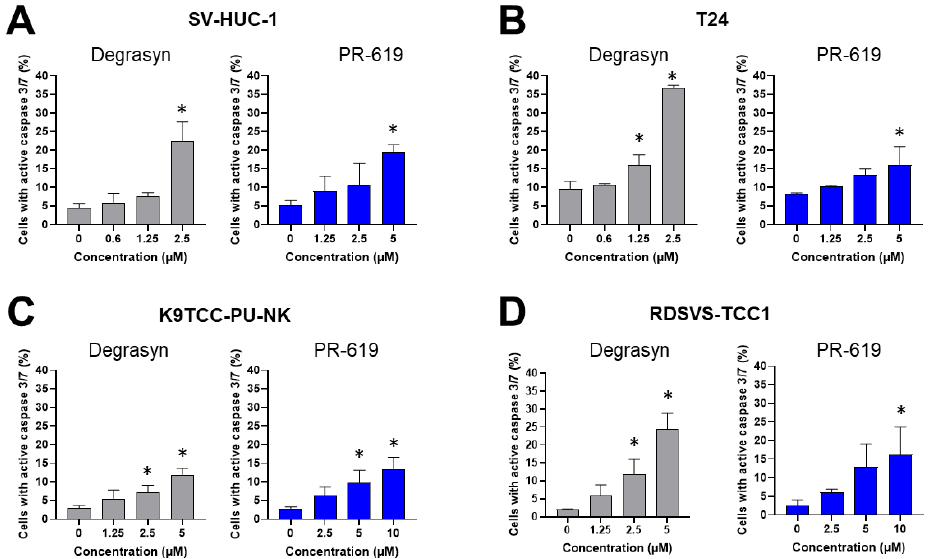
Figure 8. Evaluation of caspase 3/7 activation induced by Degrasyn and PR-619. Percentage of cells with active caspase 3/7 after 24 h exposure to increasing concentrations of Degrasyn and PR-619 in: ( A ) SV-HUC-1, ( B ) T24, ( C ) K9TCC-PU-NK, and ( D ) RDSVS-TCC cell lines. Values are expressed as the means ± standard deviations (SD) of three independent experiments. * Considered significant in comparison to control ( p < 0.05).